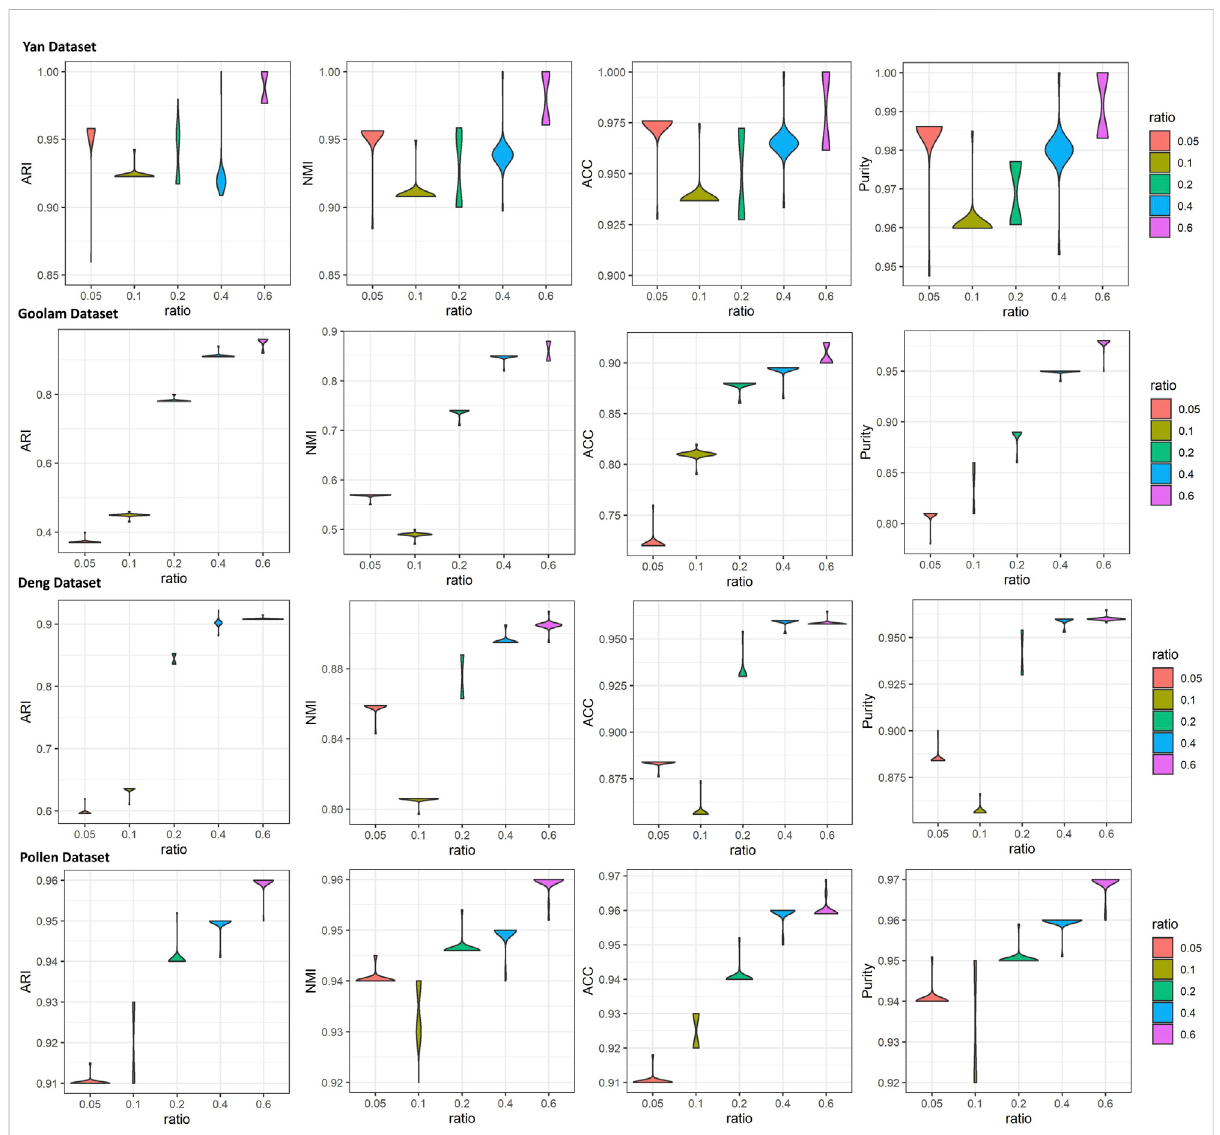
FIGURE 3 iolin plots of clustering evaluations (ARI, NMI, ACC, and purity) of LFSC with different downsampling ratios for four highly con fi dent scRNA-seq